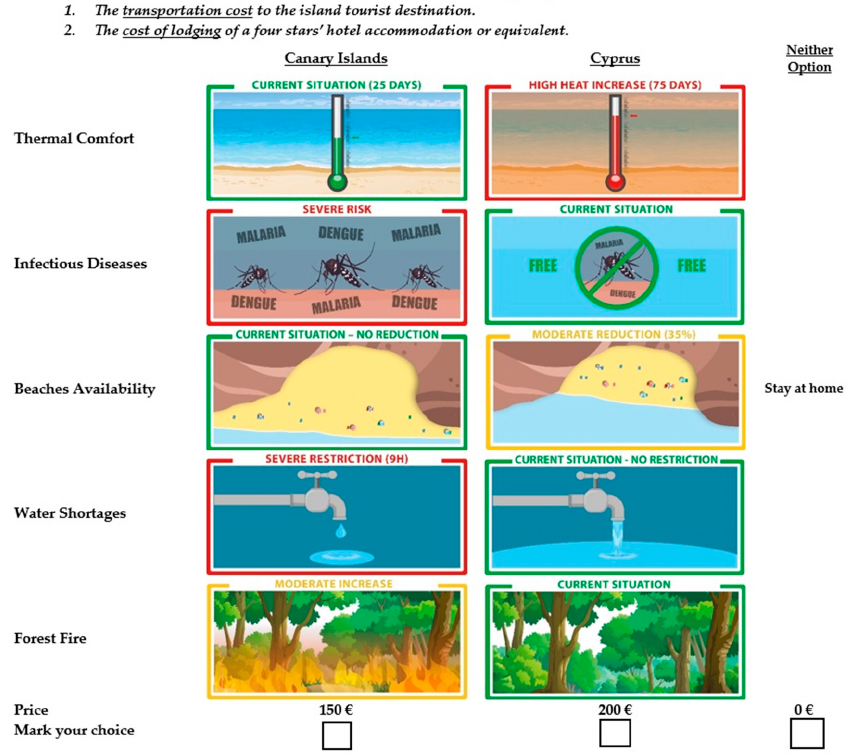
Figure 2. Example of choice card utilised in the survey.